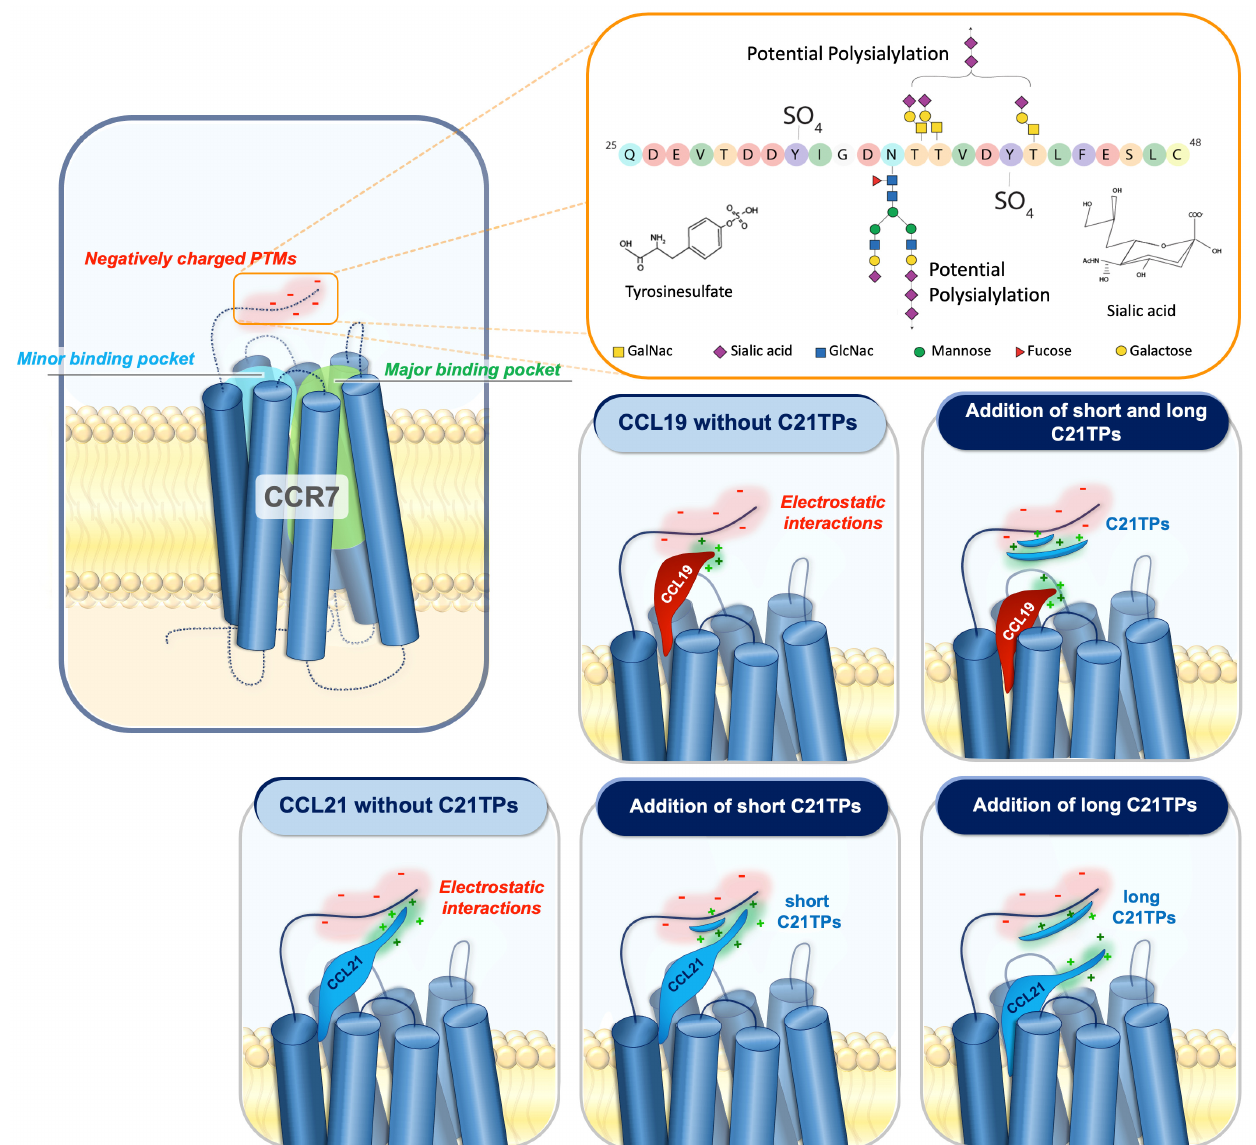
Figure 7. The addition of free CCL21 C-terminal peptides affects chemokine–receptor interaction. Negative amino acids and/or posttranslational modifications (PTMs) such as sialy- lated and polysialylated N- and O-glycans and tyrosine sulfation at the N-terminus of CCR7 may affect the docking of CCL19 and CCL21 due to their positively charged C- terminal regions encompassing BBx(x)B motifs. Electrostatic interactions between the basic C-terminus of CCL19 and CCL21 and negatively charged PTMs in the CCR7 N-terminus restrain both chemokines from docking optimally into the receptor-binding pocket. CCL19 contains a short basic C-terminus with a few basic residues. The addition of both short and long C21TPs shields the negative charges in the CCR7 N-terminus enough to allow the proper receptor-docking of CCL19 and thus boosts signaling. In contrast to CCL19, CCL21 contains a long basic C-terminus, and thus the addition of short C21TPs does not shield the negative charges enough to prevent electrostatic interactions between the CCL21 C-terminus and the CCR7 N-terminus, whereas the addition of long C21TPs shields the negative charges sufficiently, allowing the optimal docking of CCL21 into the